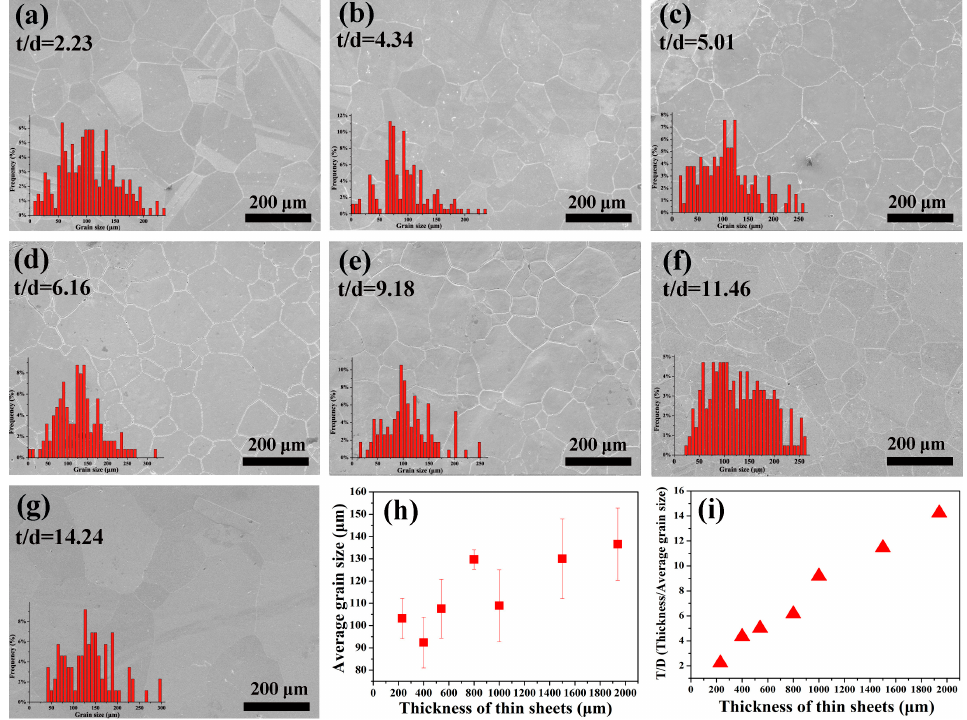
Figure 4 . SEM images with various thickness: ( a ) 230 μ m; ( b ) 400 μ m; ( c ) 540 μ m; ( d ) 800 μ m; ( e ) 1000 Figure 4. SEM images with various thickness: ( a ) 230 µ m; ( b ) 400 µ m; ( c ) 540 µ m; ( d ) 800 µ m; μ m; ( f ) 1500 μ m; ( g ) 1940 μ m; and ( h , i ) show the plot of average diameters and T / D with the thickness ( e ) 1000 µ m; ( f ) 1500 µ m; ( g ) 1940 µ m; and ( h , i ) show the plot of average diameters and T / D with the of thin sheets, respectively (the inset shows the grain size–frequency column plots). thickness of thin sheets, respectively (the inset shows the grain size–frequency column